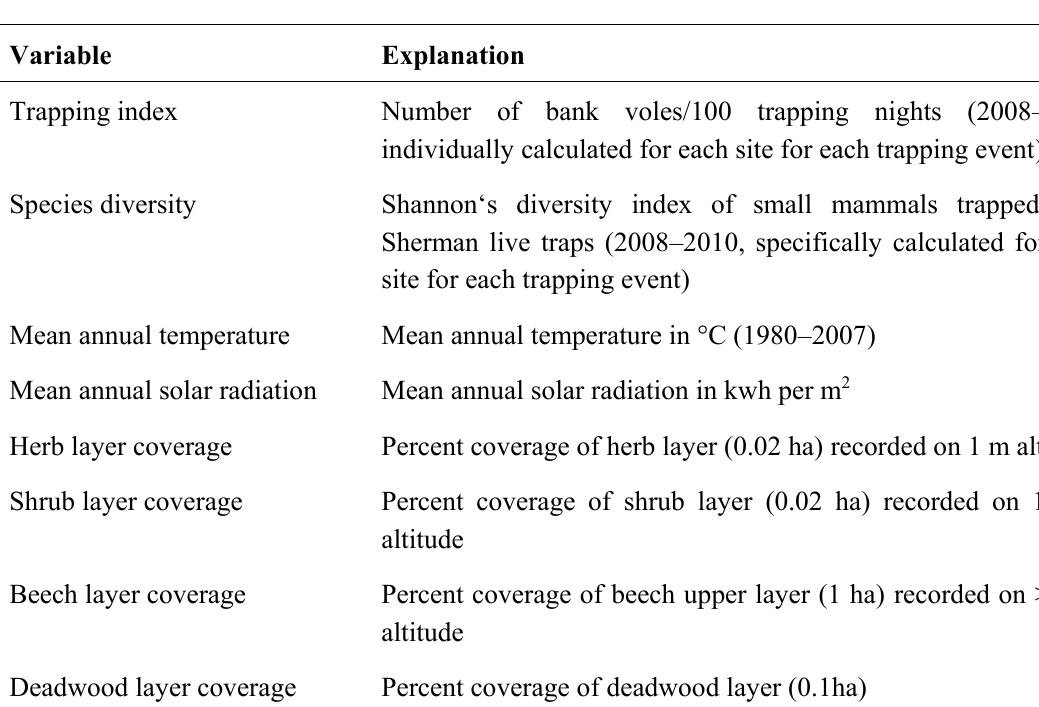
Table 4. Description of the variables within the data set (climate and vegetation composition) used to predict PUUV prevalence in bank voles along two altitude gradients in the BFNP in a